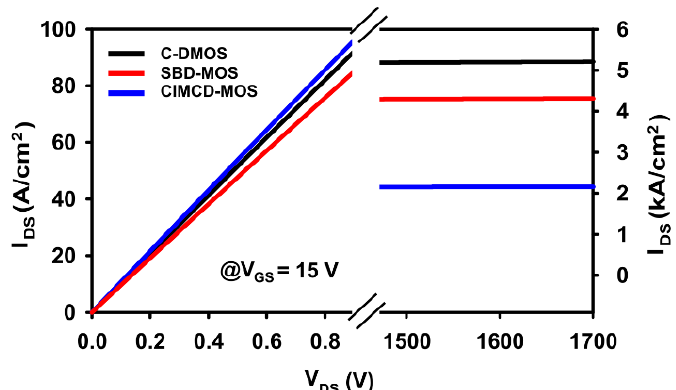
Figure 5. On-state characteristics of C – DMOSFET, SBD – MOSFET, and CIMCD – MOSFET.